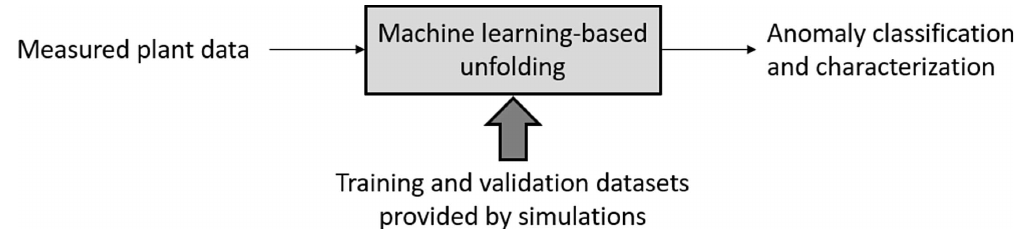
Fig. 1. Overview of the overall core monitoring methodology applied in the CORTEX project. simulations with uncertainty and sensitivity